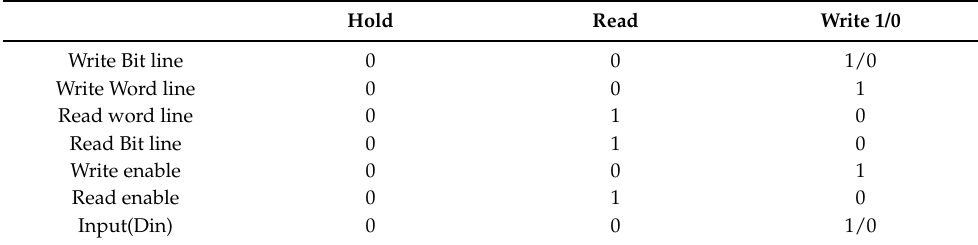
Figure 21. Proposed SE 8T SRAM cell operation. Table 4. Status of control signals for proposed SE 8T